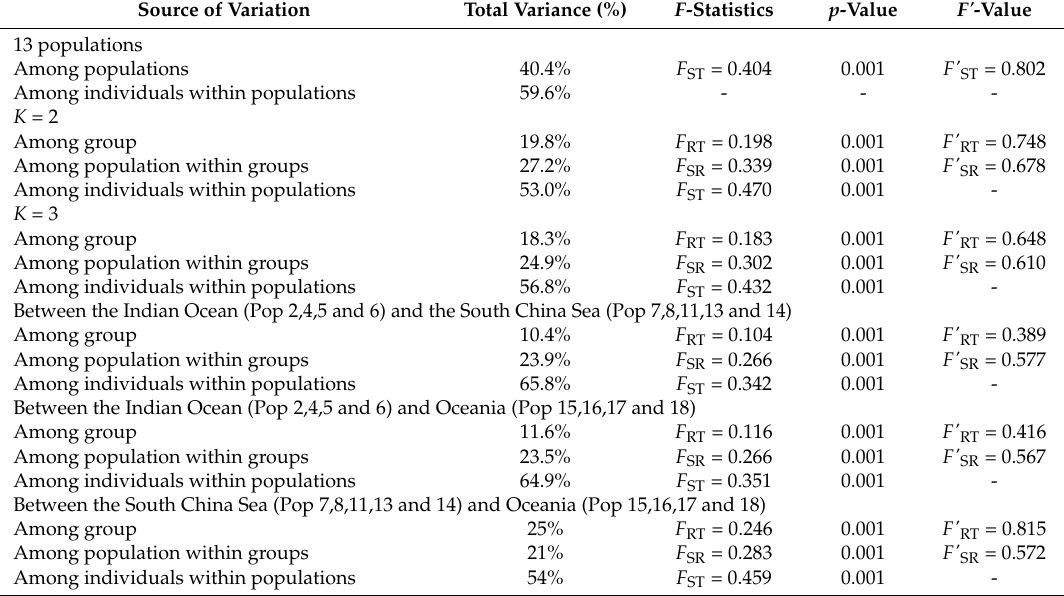
Table 3. Analysis of molecular variance (AMOVA) for 50 individuals of X. granatum based on 11 nuclear